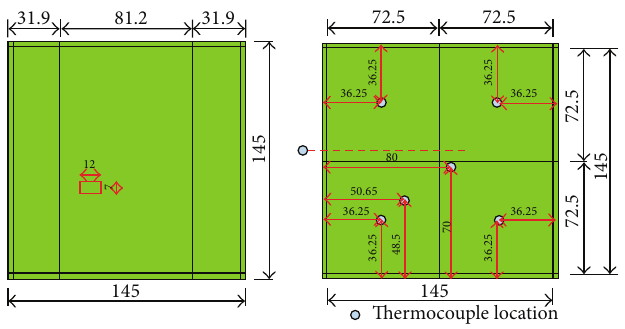
Figure 4: Test 2 ∼ Test 6: exposed surface and unexposed surface of specimen and geometry of the thermocouple (the arrangement of boards and measuring points of specimens for Test 2 ∼ Test 6).